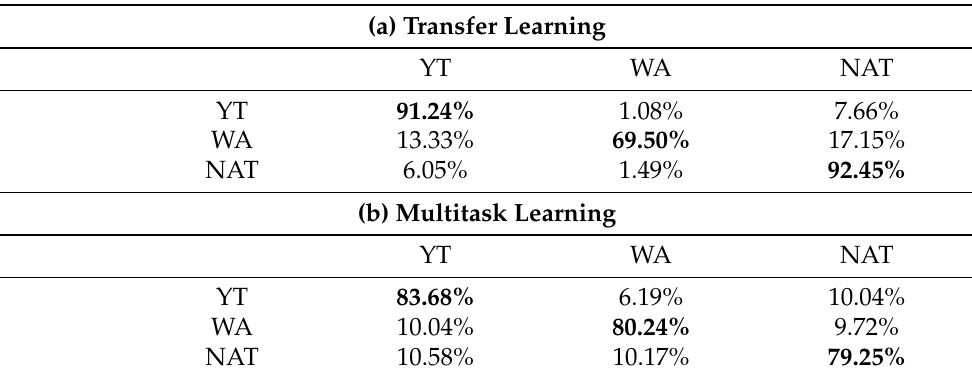
Table 4. Confusion matrices on video patches of the transfer-learning (a) and multitask learning (b) models sharing the constrained and conv1 layers.